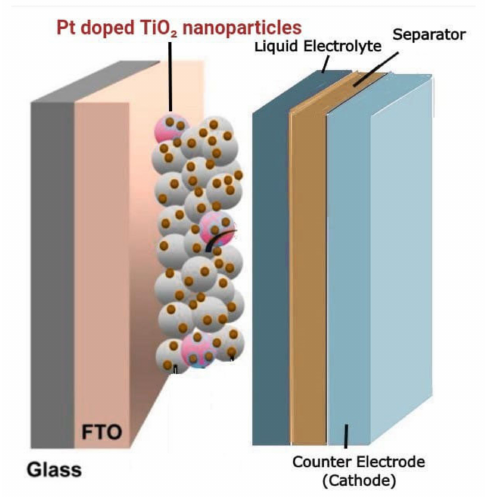
Figure 1. Schematic of TiO 2 -based